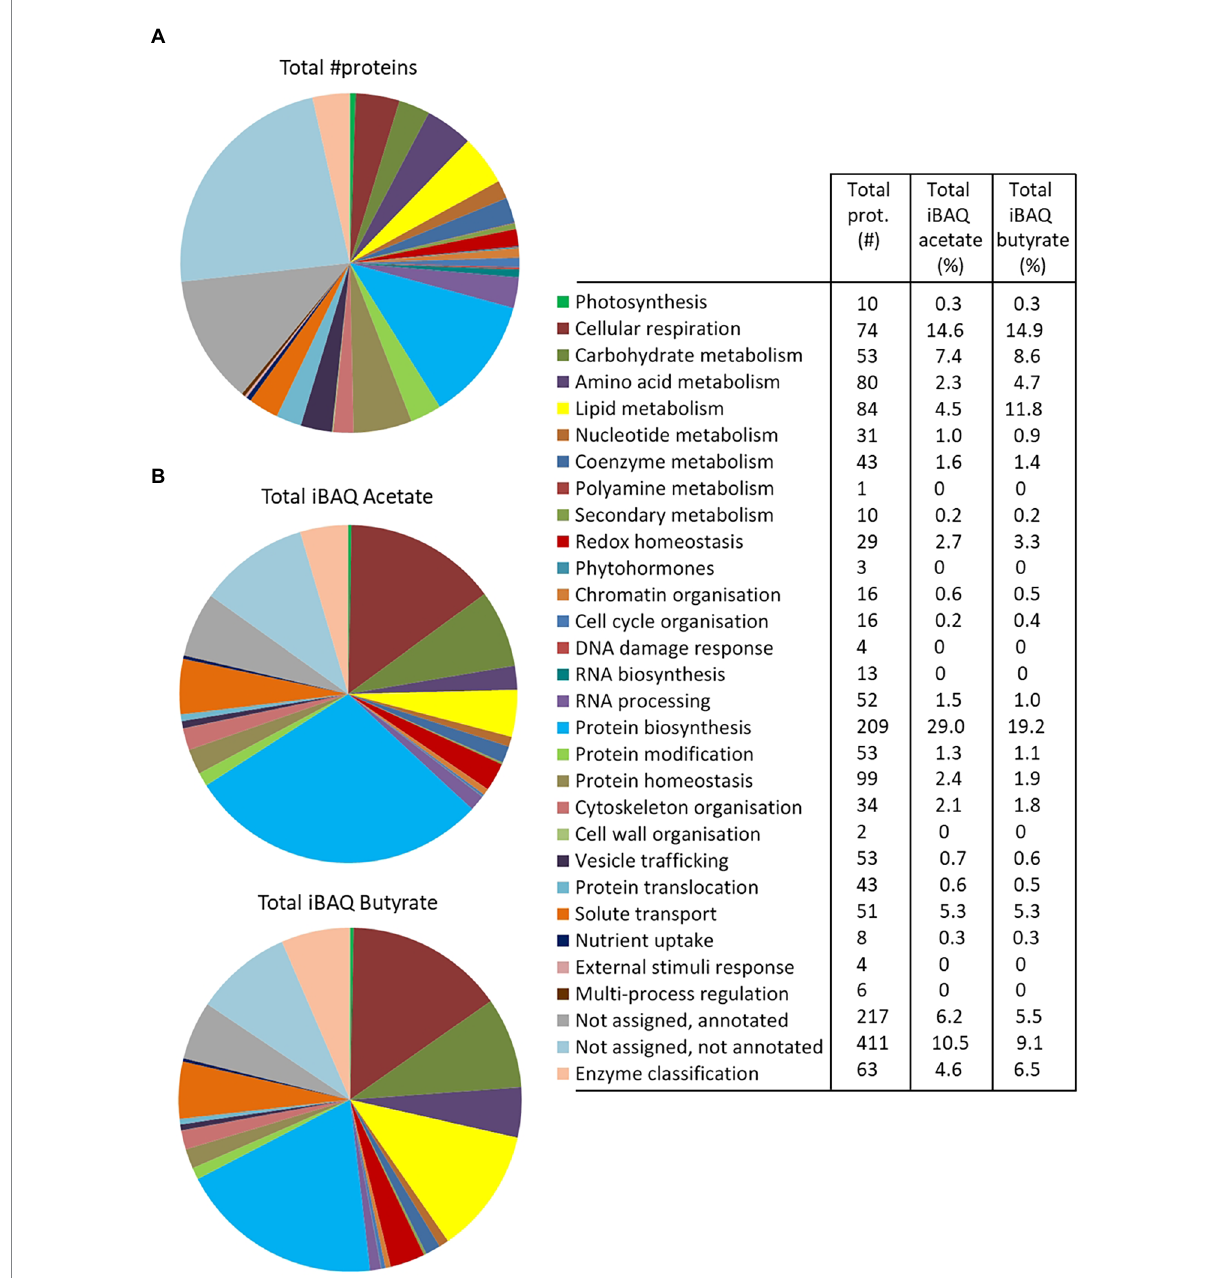
FIGURE 3 Overview of the Polytomella proteome revealed by the differential approach, represented per metabolic category as determined by Mercator. (A) Total number of proteins identified in both acetate and butyrate-growing cells. (B) Cumulative iBAQ values of total acetate and butyrate proteomes give an indication of the total protein abundance per category. The values associated to the graphs are indicated in the